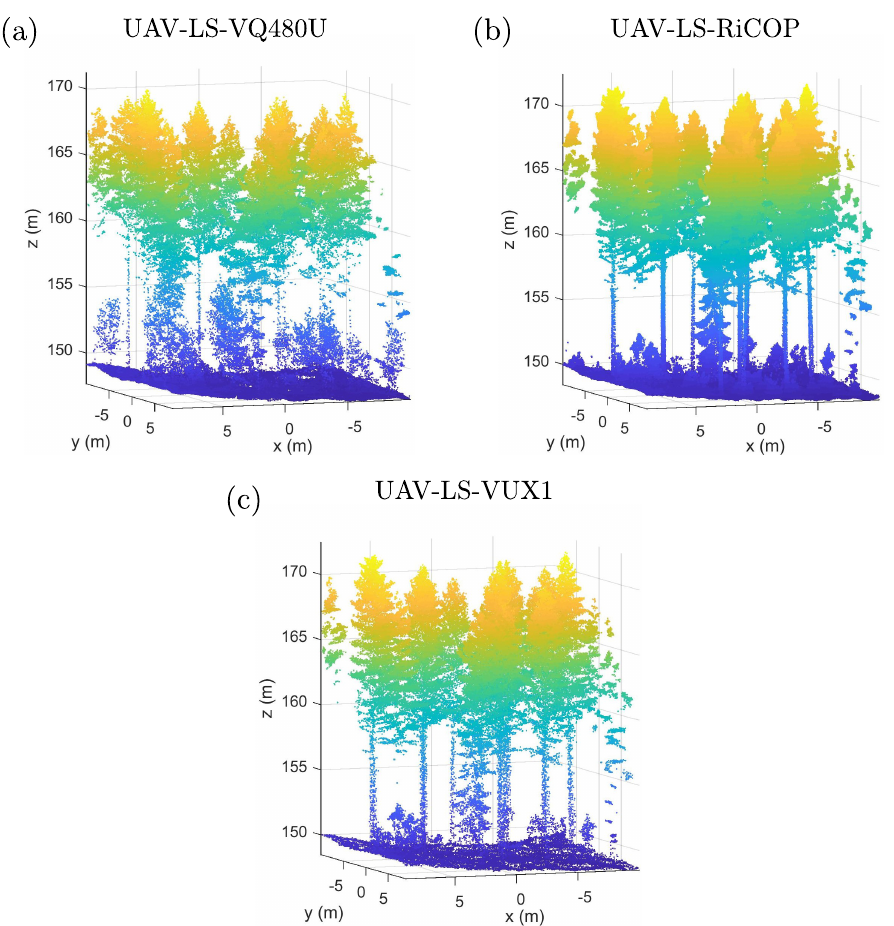
Figure 8. Point clouds of the sparse test site obtained with the different above-canopy flying UAV systems: ( a ) UAV-LS-VQ480U, ( b ) UAV-LS-RiCOP, and ( c )